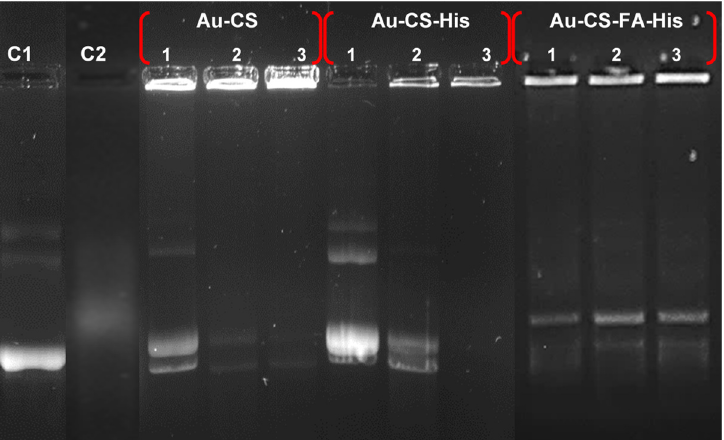
Figure 6. The nuclease protection assay of the nanocomplexes. Lane 1: positive control (untreated pDNA) and lane 2: negative control (pDNA digested with 10% FBS). Lanes 1: suboptimum ratio, 2: optimum ratio and 3: supraoptimum ratio for the indicated nanocomplex, as per Table 2.